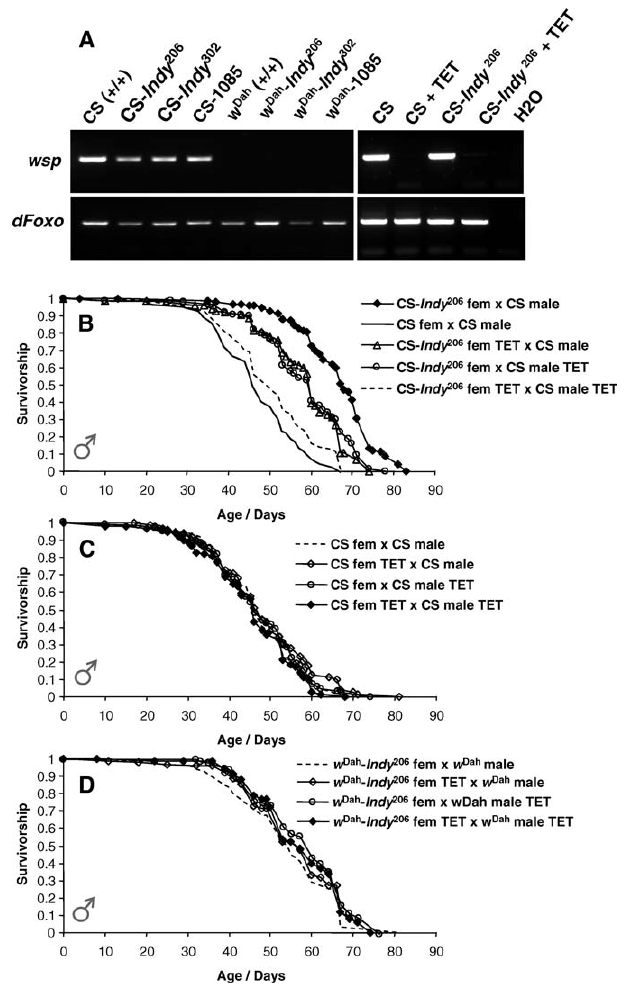
Figure 5. Tetracycline Treatment Greatly Modulates Indy 206 -Related Longevity Crosses conducted to obtain male progeny for lifespan experiments are shown next to the symbol keys (mothers left, fathers right). All lifespan experiments were carried out on SY food. A) Detection of Wolbachia infection by PCR using primers specific to Wolbachia surface protein ( wsp, upper panels). dFOXO was amplified as a control for DNA quality (lower panels). The original Canton S background is infected with Wolbachia and this infection is absent in w Dah background (upper left panel). TET treatment removed Wolbachia from infected lines (upper right panel). B) TET treatment of parents drastically shortens lifespan of long-lived CS- Indy 206 / þ males. All experimental flies are heterozygous for Indy 206 , except the CS control. Treatment father or mother alone had an equal effect on lifespan of the progeny (Log-Rank test v 2 ¼ 0.31, p ¼ 0.5794). When both parents were treated, the CS- Indy 206 / þ progeny was slightly but significantly different from the Canton S control (Log-Rank test v 2 ¼ 6.86, p ¼ 0.0088). All other conditions were significantly different from each other (Log-Rank test, p , 0.0001). C) TET treatment of parents has no effect on lifespan of Canton S control males. All experimental males are wild type (CS). There are no statistical differences among any conditions (Log-Rank test, p . 0.065). D) Crosses similar to those in (B) were conducted using w Dah - Indy 206 flies. No significant differences were found (Log-Rank test, p . 0.145), except when progeny of nontreated parents were compared with progeny of parents where fathers were TET treated (Log-Rank test v 2 ¼ 4.13, p ¼ 0.0422). fem,